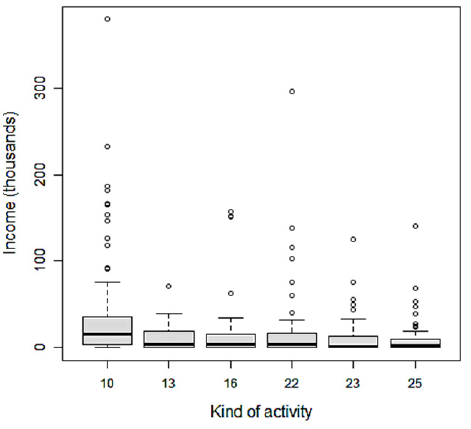
Figure 1. Study population by the kind of economic activity.